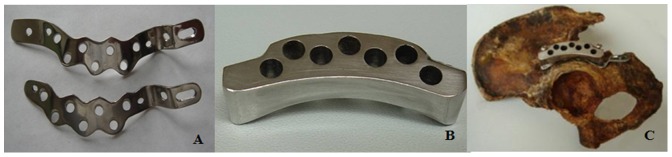
The W-shaped acetabular angular plate (A), the safe-angled drilling guild(B), and both of them assembled(C).